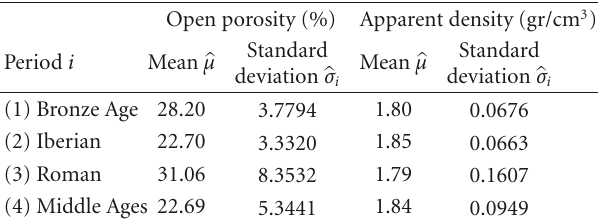
Table 4: Porosity and density statistics of the prior